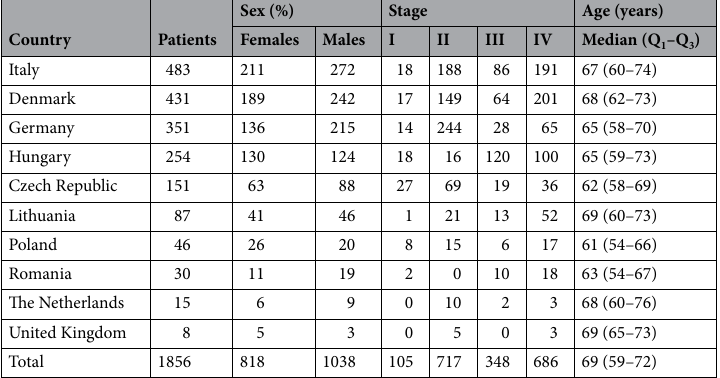
Table 1. Description of the study